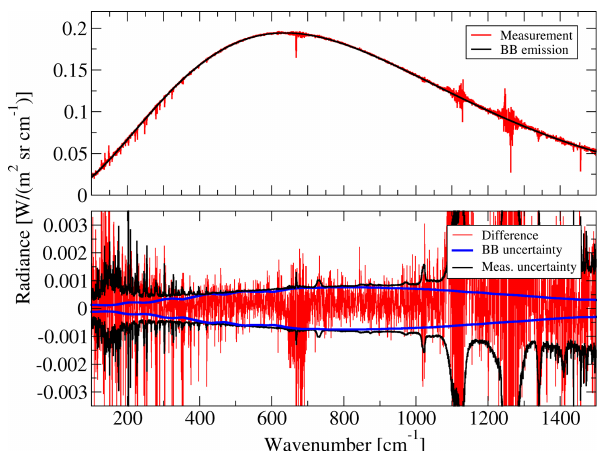
Figure 8. Measurement of a reference calibration blackbody source at about